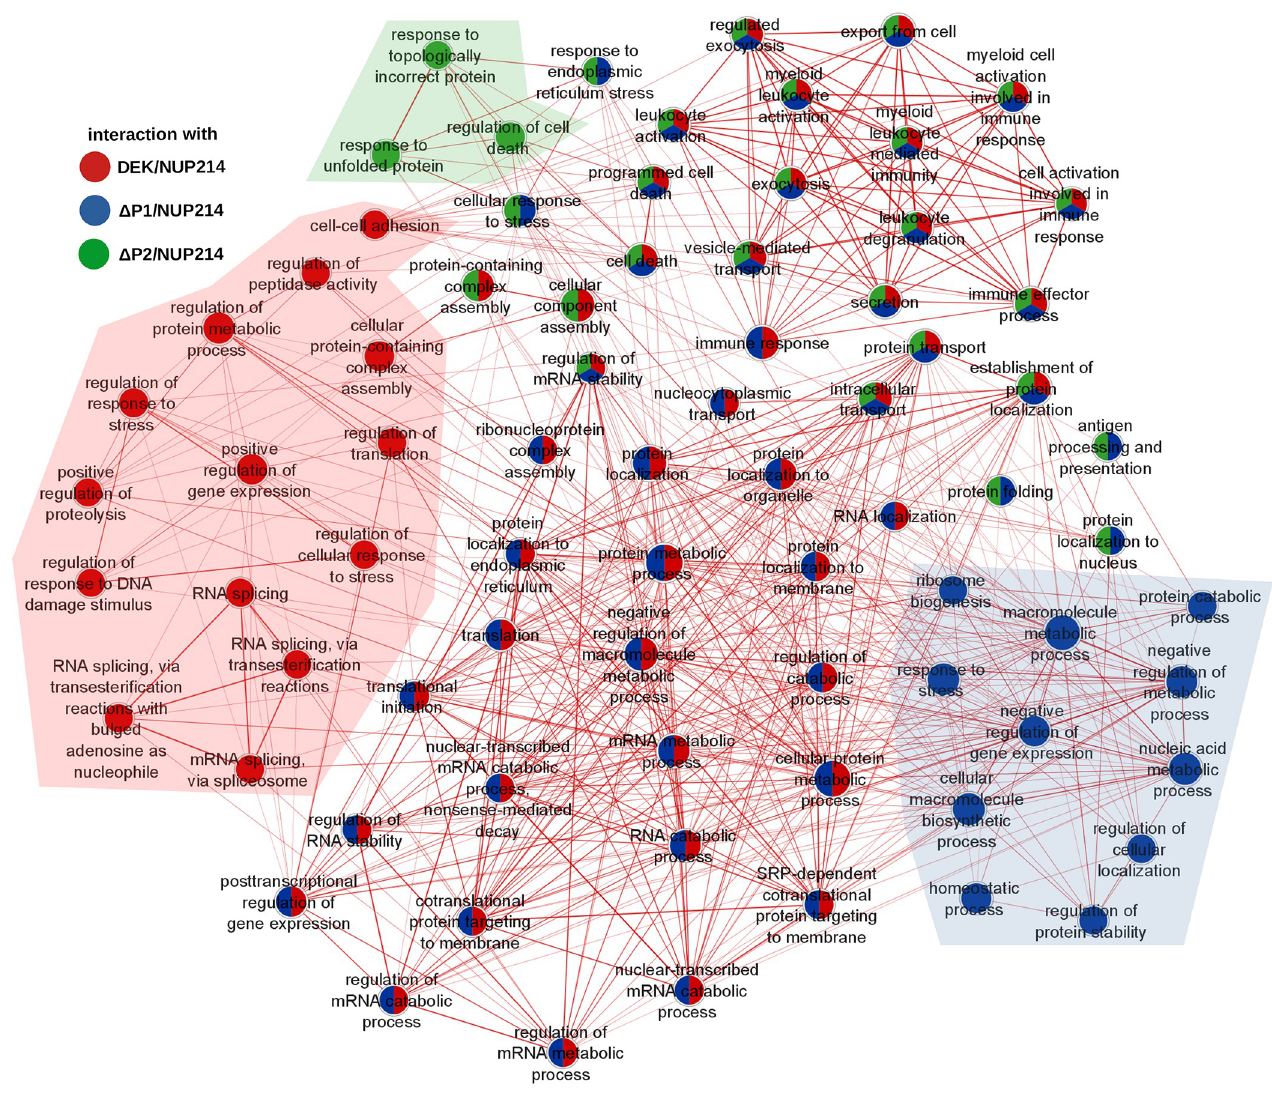
Fig 5. Bioinformatic analysis of biological processes comparing the interactome of DEK/NUP214 with those of its mutants in g:Profiler and Cytoscape. Gene set size was set as 10–100 genes/set. The output from the analysis of the interactomes in g:Profiler was refined and compared in Cytoscape/ EnrichmentMap using an edge cut-off of 0.7. A set had a p � 0.05). Red: DEK/NUP214; blue: Δ P1/NUP214; green: Δ P2/NUP214.